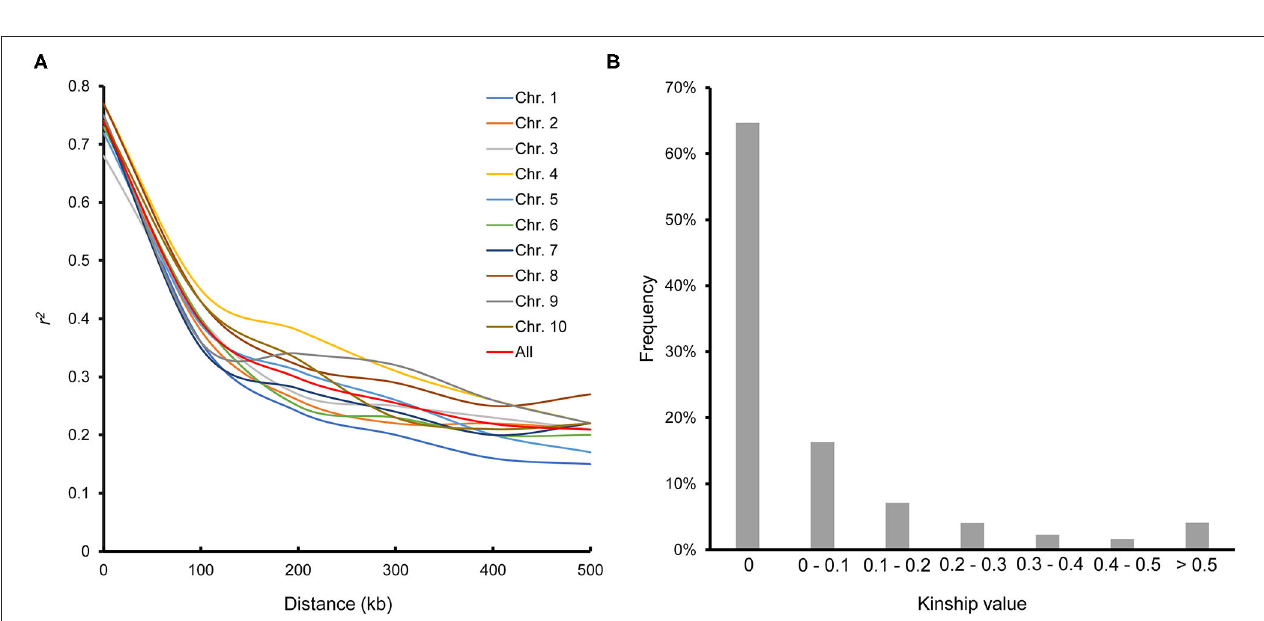
FIGURE 2 | Linkage disequilibrium across the 10 chromosomes (A) and pairwise relative kinship for 251 maize inbred lines (B) .